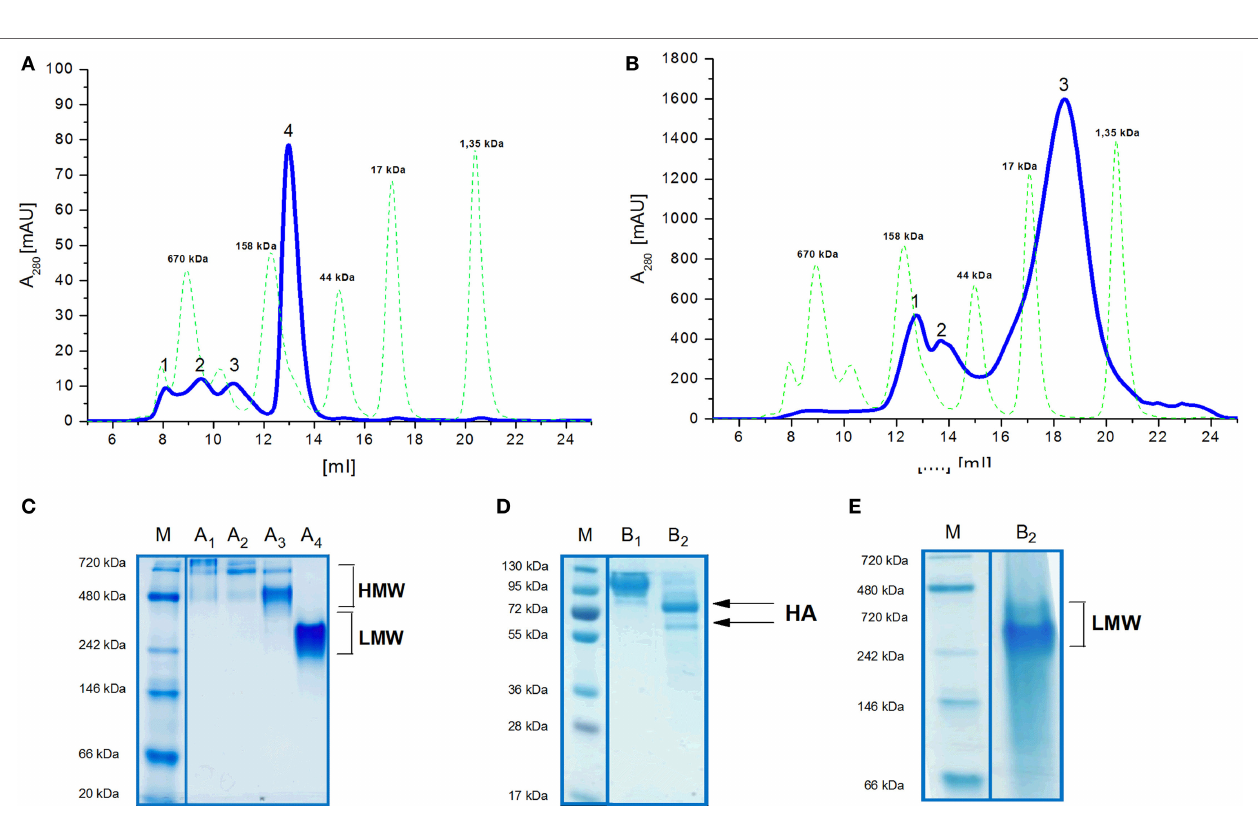
FigUre 2 | structural representations of the molecular models of N -glycosylated h5 hm (a,B) and h5 Man5 (c,D) monomers and trimers . HA1 domain was depicted in blue ribbon representation, HA2 domain—in green one, and oligosaccharides—in orange atomistic ball one. The sugar-bonded asparagines were also depicted in atomistic representations according to their respective domain colors. The models were constructed based on the crystallographic structure of the H5 hemagglutinin (PDB ID code 5E2Y).